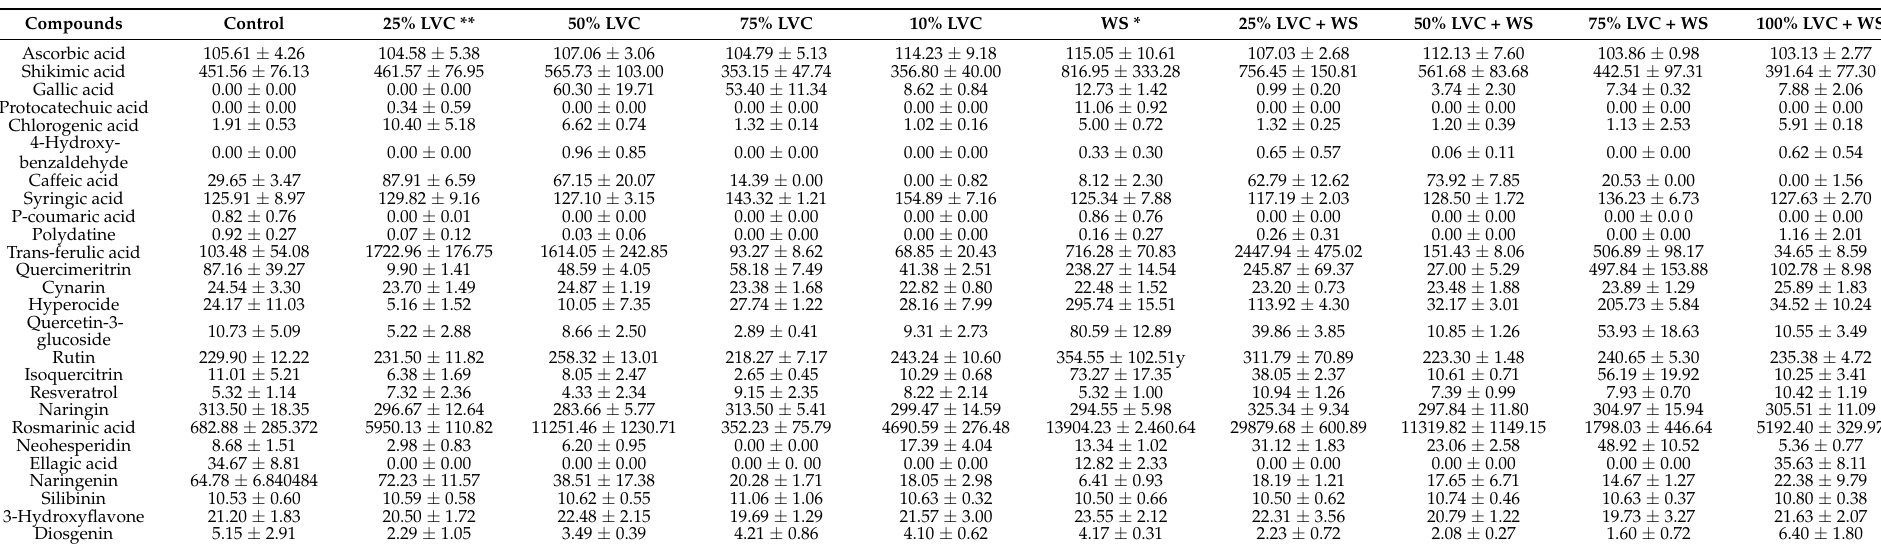
Table 4. Effects of liquid leachate obtained from vermicompost (25, 50, 75, and 100%) on phenolic acids and flavonoids in basil leaves under water stress conditions